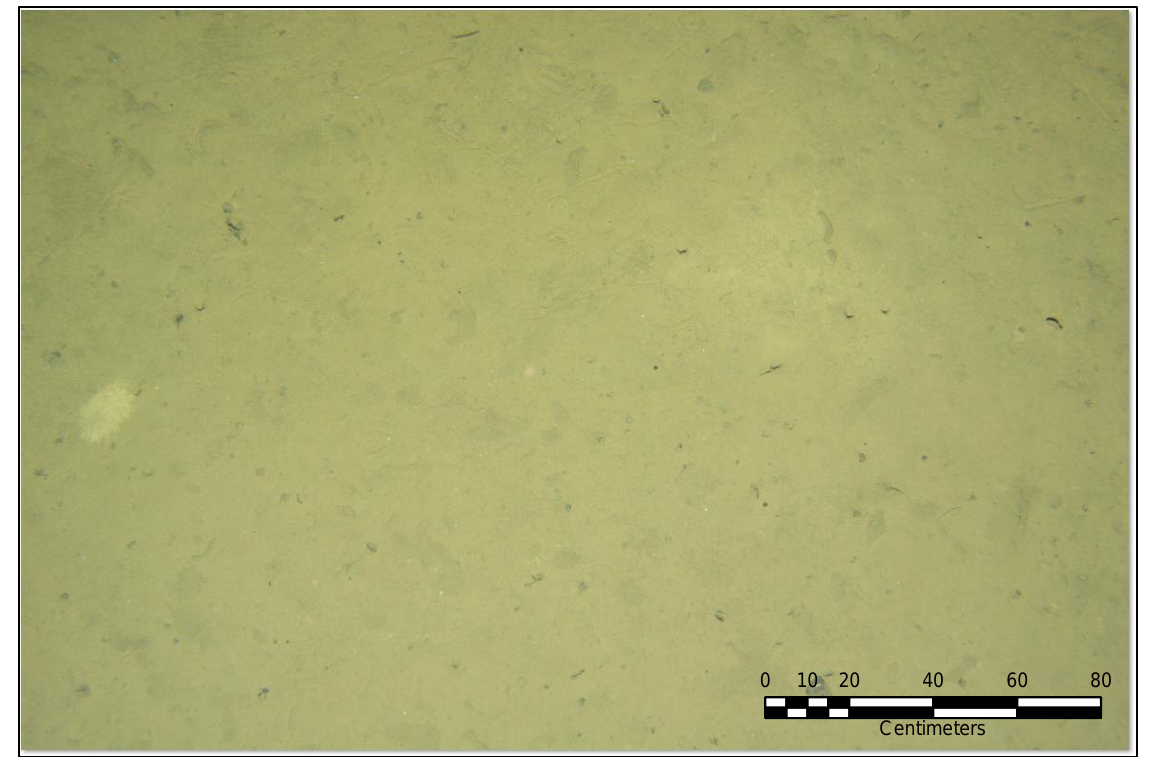
Figure 10. Example sub-bottom profiler image of the host/basement for the nodule deposit.